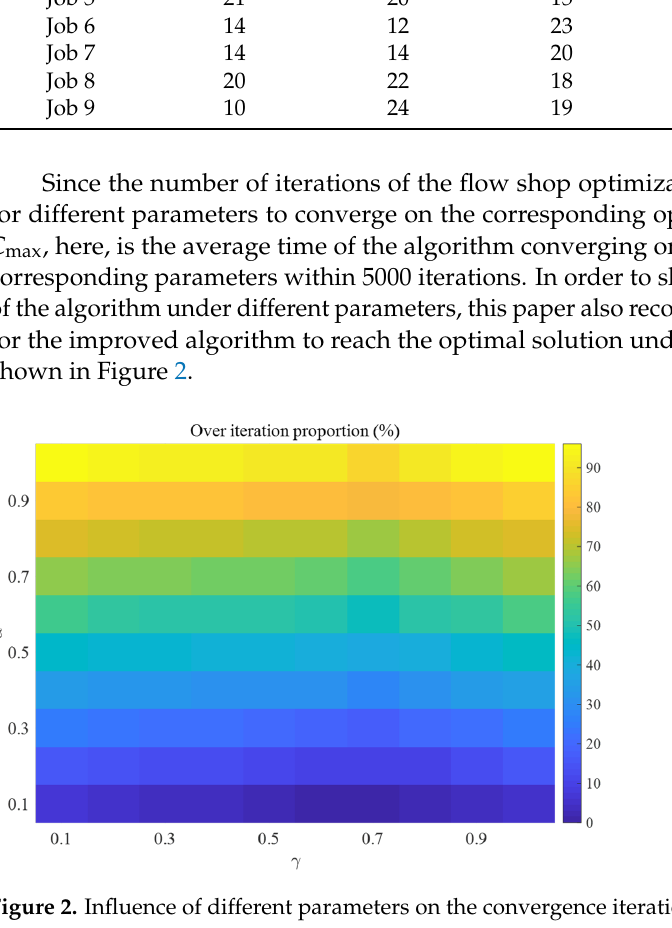
Figure 3. Comparison of impacts on average finishing time of different parameters, before and after the improvement. 0.1 0.2 0.3 0.4 0.5 0.6 0.7 0.8 0.9 1.0251.8252252.2252.4252.6252.8253 253.2 M ea n C m a x